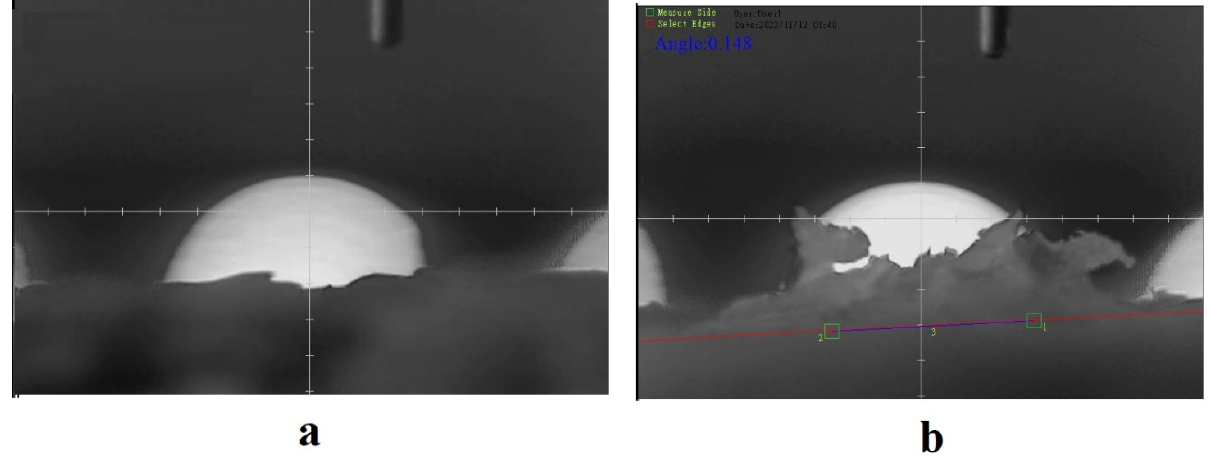
Figure 9. Contact angle for AR adsorbent: ( a ) before adsorption; ( b ) after adsorption.